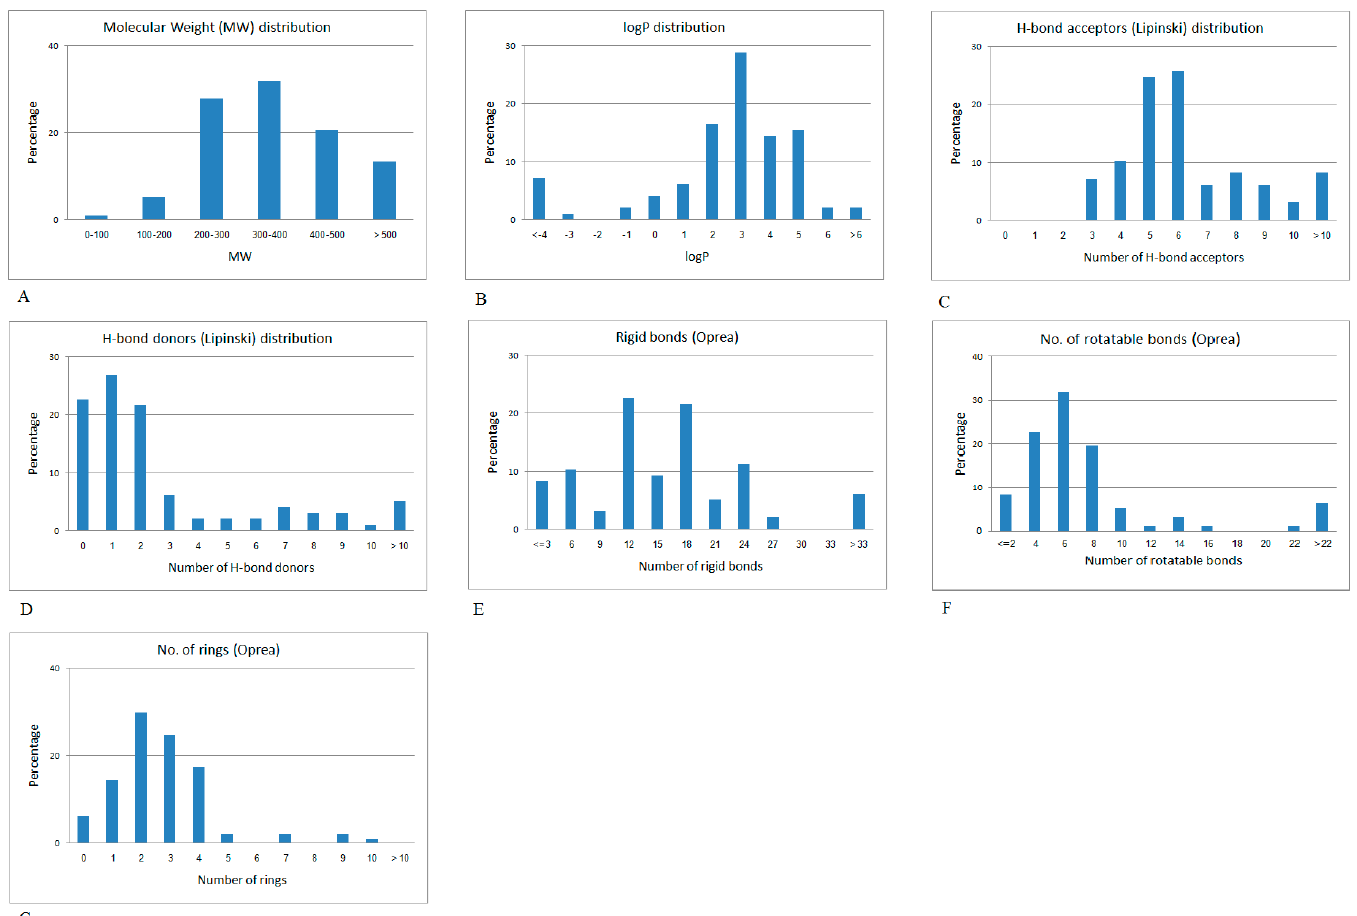
Figure 4. Physicochemical property distribution of anti-diabetic drugs. ( A ) Molecular weight distribution; ( B ) logP values; ( C ) the number of H-bond acceptors (lip_acc as coded by MOE software); ( D ) the number of H-bond donors (lip_don as coded by MOE software); ( E ) the number of rigid bonds; ( F ) the number of rotatable bonds; and ( G ) the number of aromatic atoms.